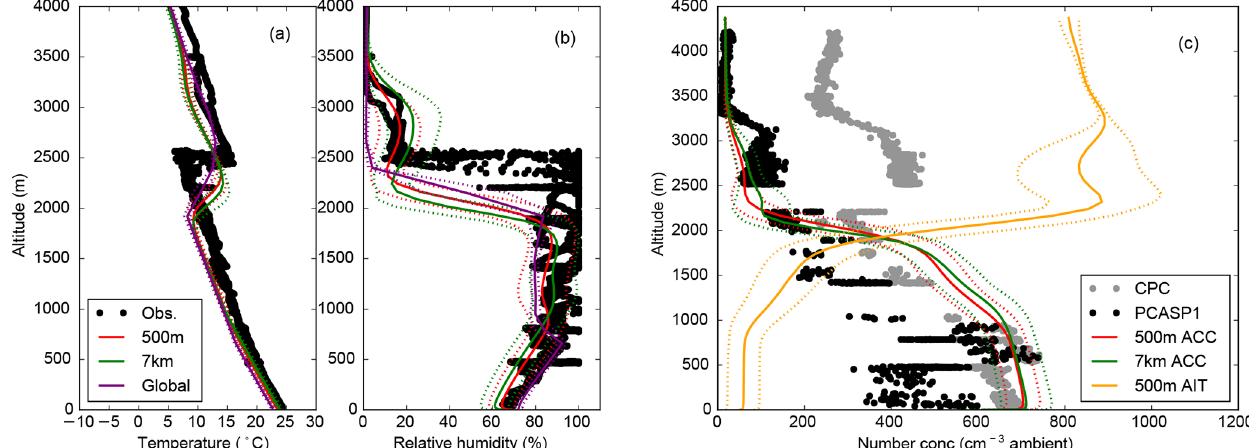
Figure 4. FAAM aircraft observations of temperature (a) , relative humidity (b) , and out-of-cloud Aitken (AIT) and accumulation-mode (ACC) aerosol number concentration (c) with the corresponding model means over the 500m domain. The aircraft data are used when- ever they are in the domain of the 500m resolution simulation. Variability across the model domain is assumed here to be small, but for accumulation-mode aerosol, it may be inferred from Fig. 2. Dotted lines indicate 1 standard deviation. Aerosol data inside clouds are re- moved as described in Sect.